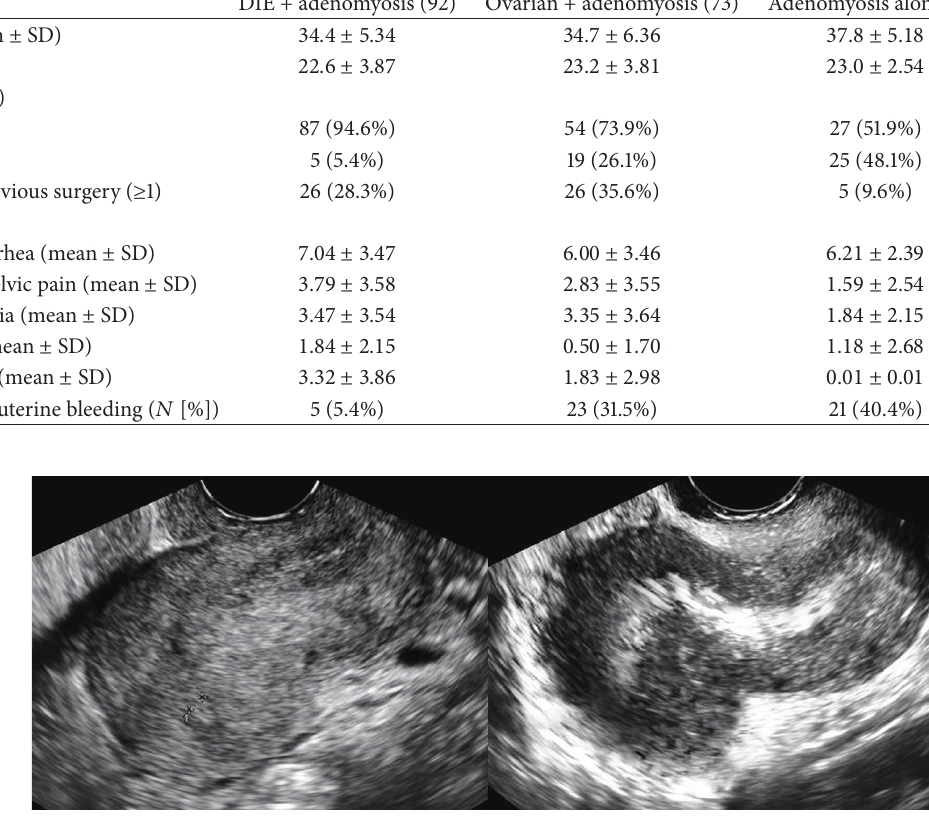
Figure 2: Ultrasound image of question mark